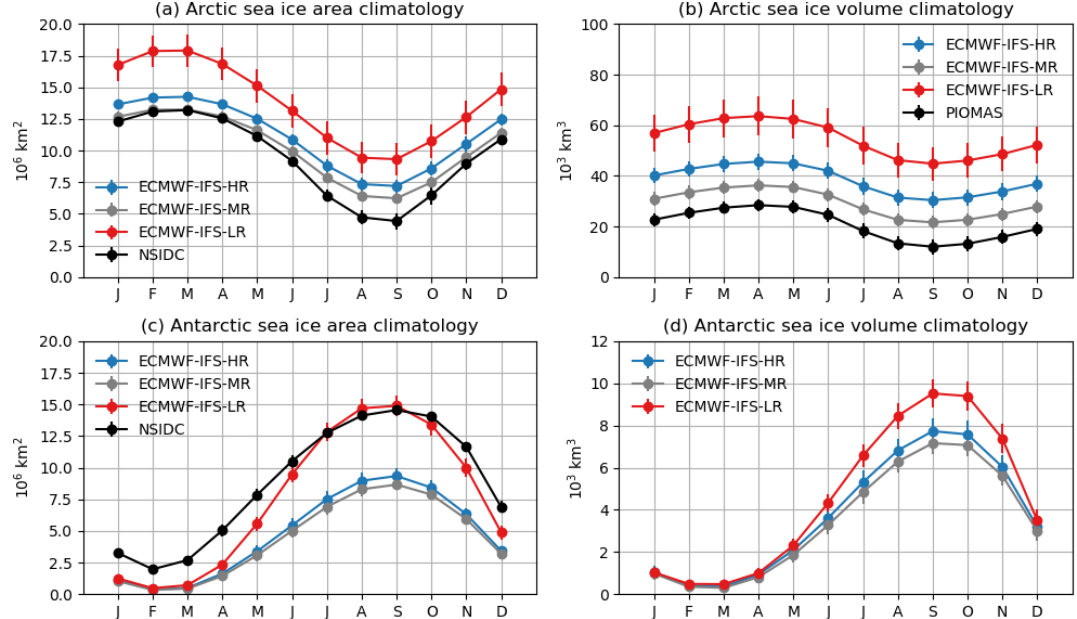
Figure 14. Monthly sea-ice area and volume climatologies for the period 1981–2010 from hist-1950 experiments. Sea-ice areas are compared to observational data from the National Snow and Ice Data Centre (NCIDC; Fetterer et al., 2017). Arctic ice volumes are compared with estimates from the Pan-Arctic Ice Ocean Modeling and Assimilation System (PIOMAS; Schweiger et al., 2011; Zhang and Rothrock,